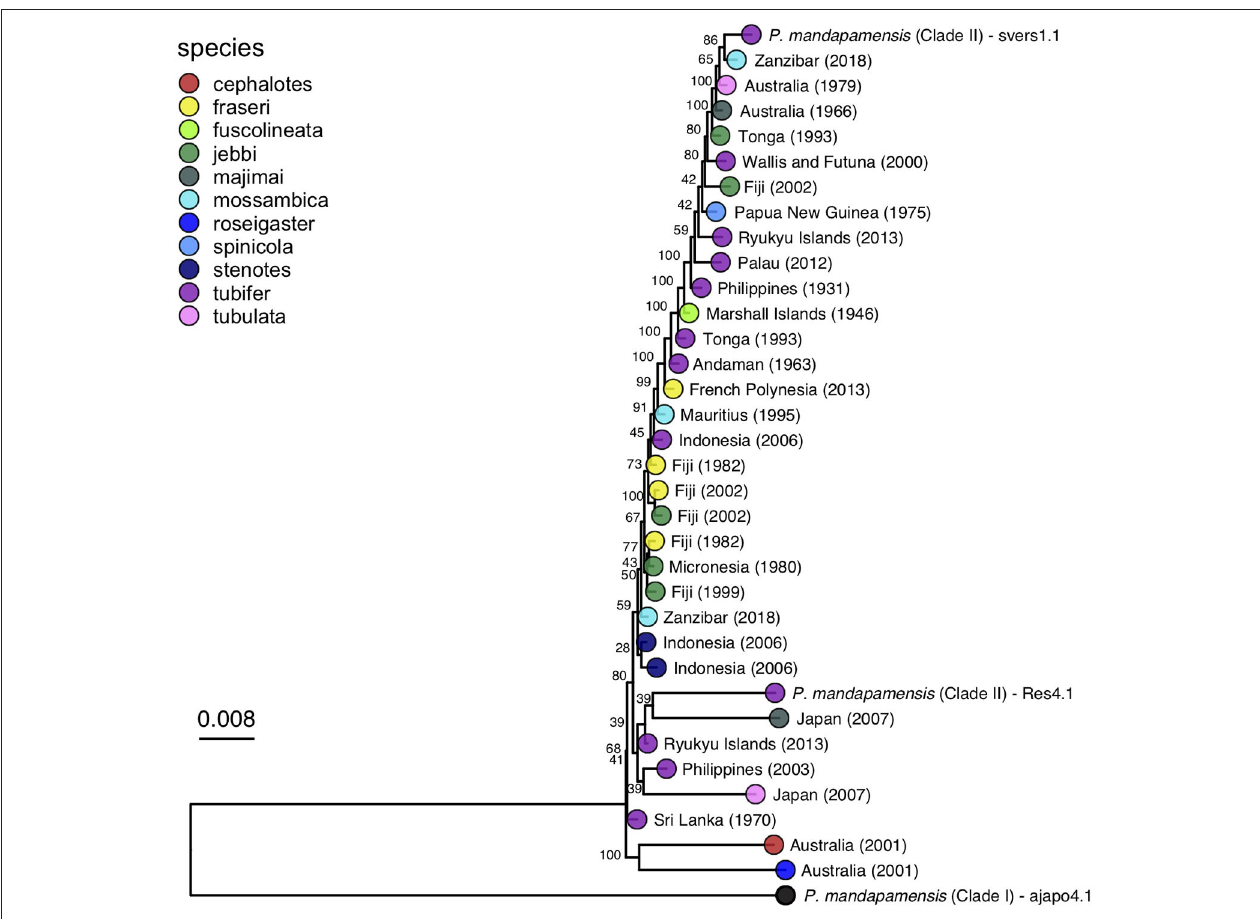
FIGURE 4 | Maximum likelihood phylogeny of the light organ symbionts of various Siphamia species constructed from a core set of 1,471 single nucleotide polymorphisms. Corresponding host species are indicated by the branch tip colors and the sampling location and year of each specimen is listed in the branch label. Bootstrap support values are indicated at each